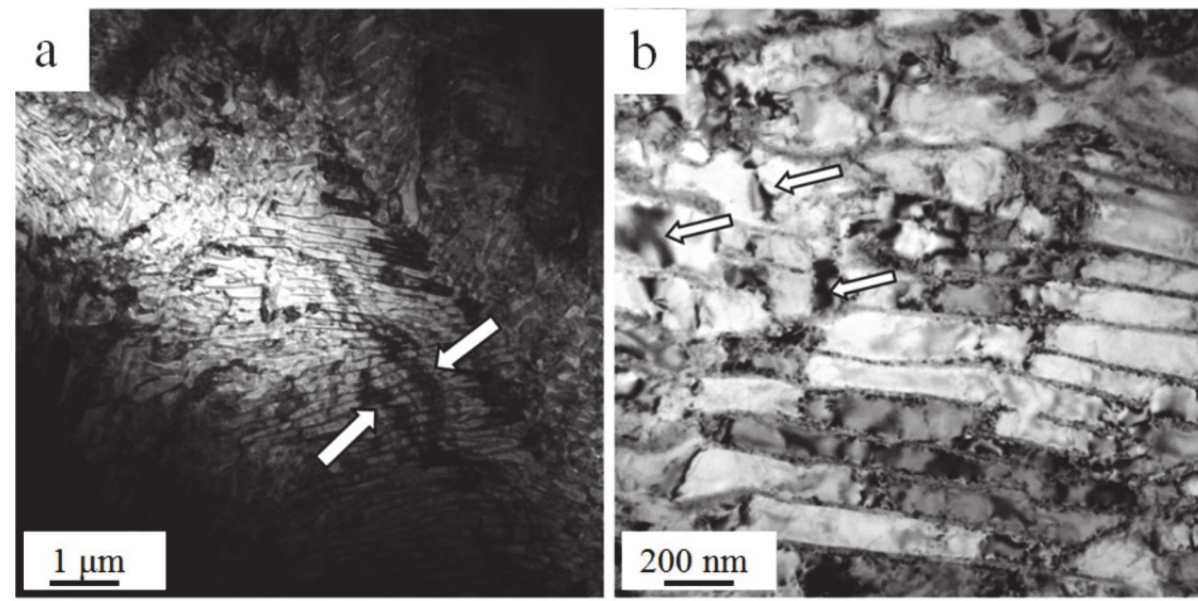
Figure 8. A structure of the deformed rail steel ( ε = 50%). Arrows indicate the bend extinction contours. ( a ) 1 µ m; ( b ) 200 nm.